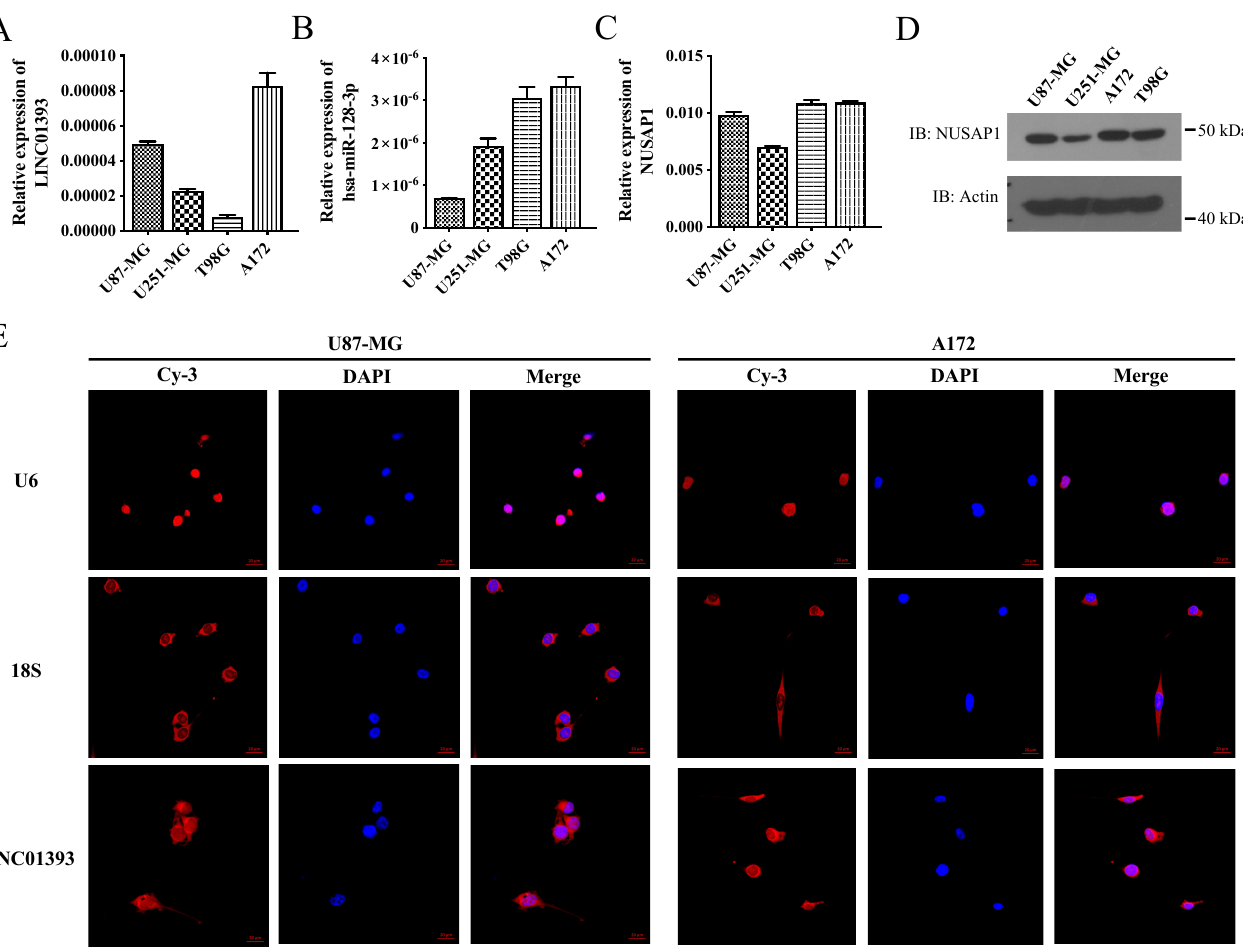
Figure 3. Expression of LINC01393, miR-128-3p and NUSAP1 in different glioma cell lines. ( A – C ) qRT-PCR analysis of LINC01393 ( A ), miR-128-3p ( B ) and NUSAP1 ( C ) expression levels in U87-MG, U251-MG, T98G and A172 glioma cells. ( D ) Western blot analysis of NUSAP1 protein expression in glioma cells. ( E ) RNA fluorescence in situ hybridization (FISH) images show that LINC01393 in U87-MG and A172 cells express in the cytoplasm. U6 and 18s rRNA are set as reference genes of the nucleus and cytoplasm respectively. Nuclei are stained with DAPI. Actin is used as a loading